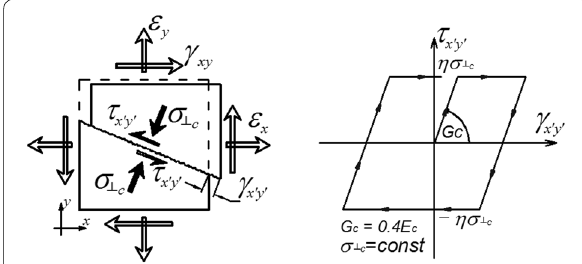
Fig. 3 Constitutive model for shear aggregate interlock along crack